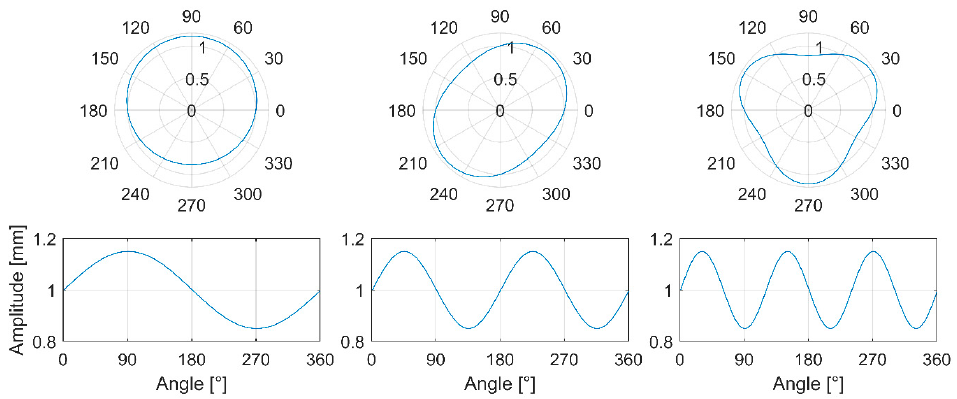
Figure 1. First three sinusoidal roundness components plotted in polar and cartesian coordinates. The Fast Fourier Transform (FFT), which is based on the Discrete Fourier Transform (DFT), is commonly applied to discrete roundness measurements to transform time domain data into a frequency domain. In practice, the results of the FFT analysis consist of a finite number of different components with certain amplitudes and phases depending on the resolution of a data acquisition. Once separated into its roundness components, it is possible to recompose the decomposed roundness